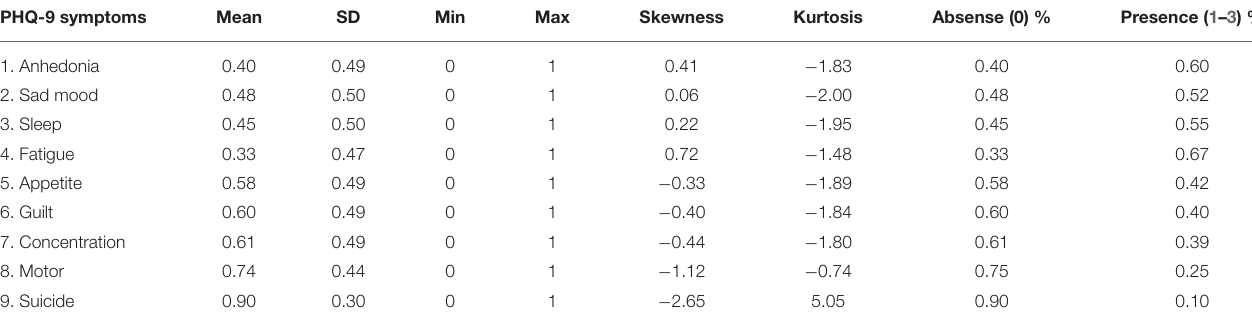
TABLE 2 | Mean, standard deviation, minimum, maximum, skewness, kurtosis, and frequency of the PHQ-9 Symptoms ( N = 2,515). PHQ-9